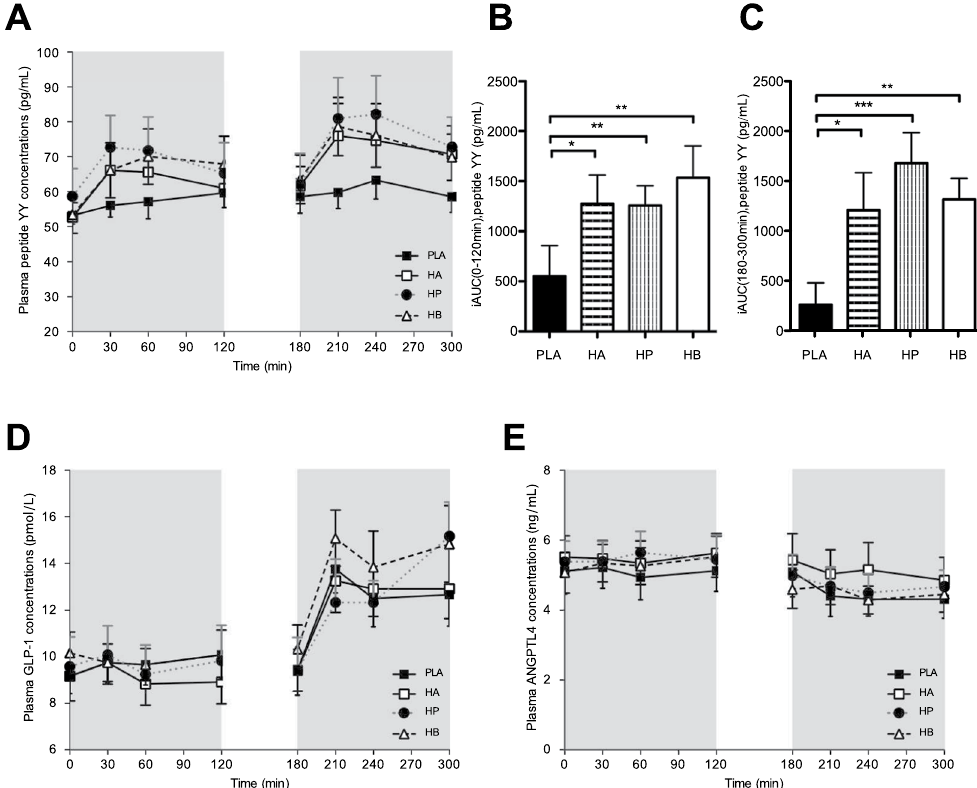
Figure 4. Effect of colonic administration of SCFA mixtures on fasting and postprandial plasma PYY ( A–C ), GLP-1 (D) and ANGPTL4 (F) ( A ) Fasting (t0–t120 min) and postprandial (t180–t300 min) plasma PYY concentrations after colonic SCFA infusions. ( B ) iAUC for fasting (t0–t120 min) plasma PYY following colonic SCFA infusion. Overall treatment effect fasting PYY P = 0.011 (period P = 0.557, carry-over P = 0.553). ( C ) iAUC for postprandial (t120–t300 min) plasma PYY following colonic SCFA infusion. Overall treatment effect postprandial PYY P < 0.001 (period P = 0.595, carry-over P = 0.184). ( D ) Fasting (t0–t120 min) and postprandial (t180–t300 min) plasma GLP-1 concentrations after colonic SCFA infusions. ( E ) Fasting (t0– t120 min) and postprandial (t180–t300 min) plasma ANGTPL4 concentrations after colonic SCFA infusions. Values are means ± SEMs (n = 12). Statistical significance indicated as asterisk ( * ) when *** P < 0.001 and ** P < 0.01 and * P <